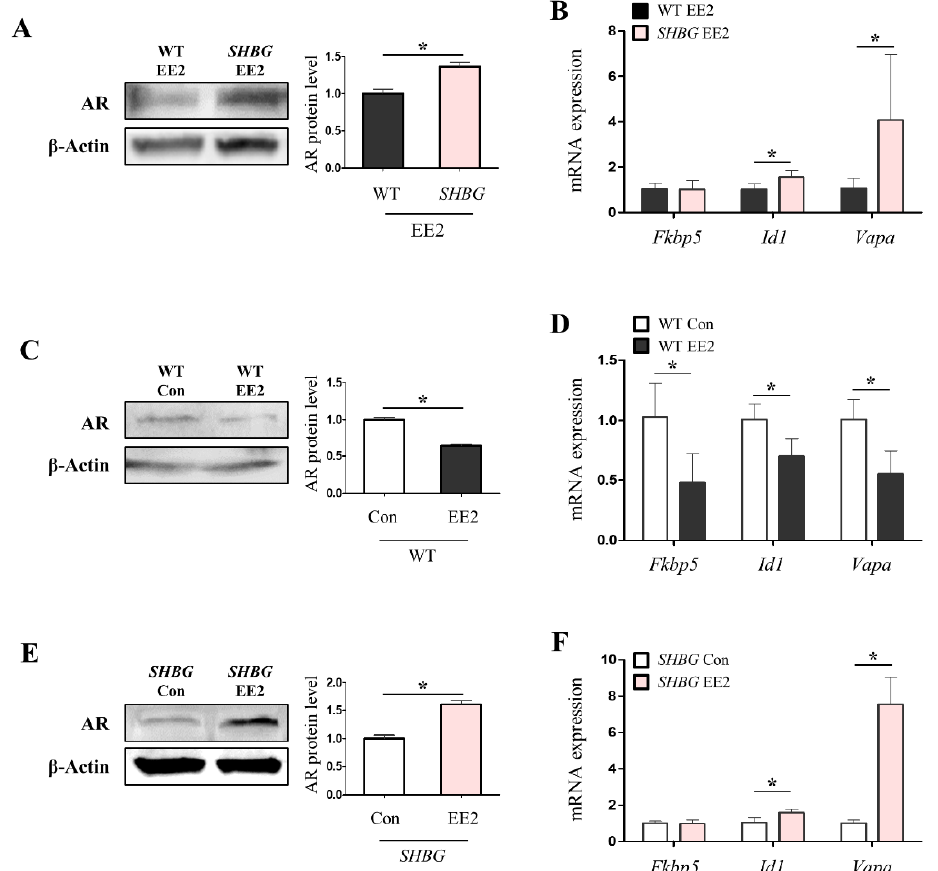
Figure 5. Androgenic effects were accentuated in SHBG mice fed with EE2. ( A ) Western blot analysis and quantification of AR in livers of WT EE2 and SHBG EE2 mice. β -Actin was used for an internal control. ( B ) mRNA expression of androgen-AR target genes, Fkbp5 , Id1 , and Vapa , in livers of WT EE2 and SHBG EE2 mice. Rplp0 was used for an internal control. ( C ) Western blot analysis and